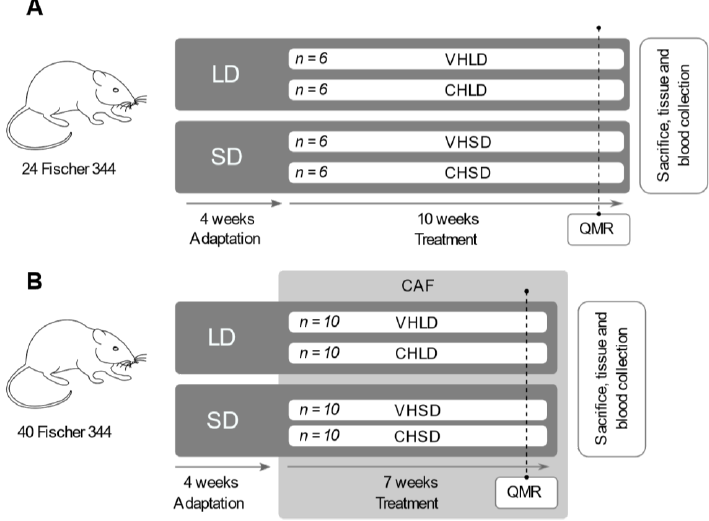
Figure 1. Experimental design of the two studies. For the first experiment ( A ), 24 Fischer 344 rats fed with a standard chow diet were randomly distributed into four groups ( n = 6) and acclimated to a long (LD) or a short (SD) photoperiod (18 h light: 6 h dark; 6 h light: 18 h dark, respectively) over 4 weeks. After the adaptation period, animals were treated with 100 mg/kg body weight of cherry lyophilizate (CH) or 20 mg/kg of the vehicle solution (VH) for 10 weeks. One week prior to sacrifice, fat mass